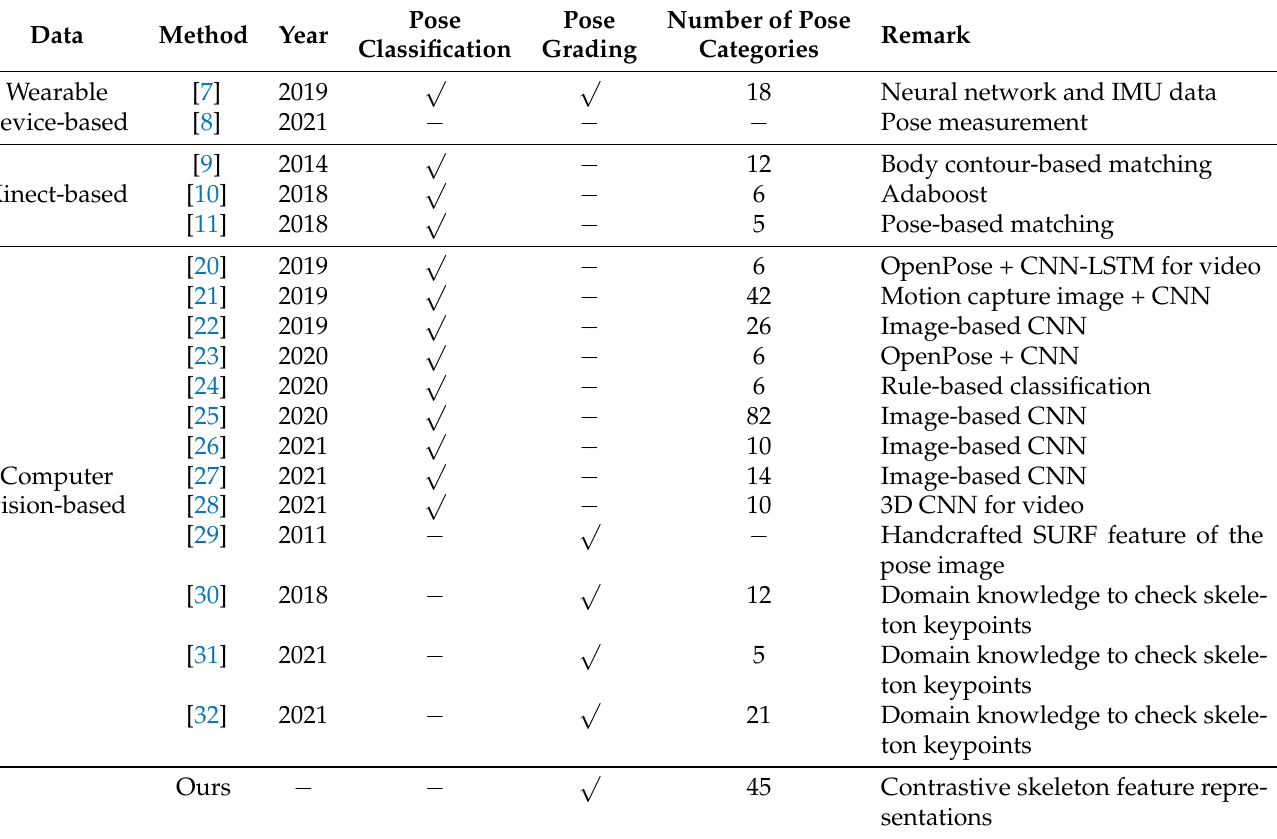
Table 1. An overview of related yoga pose classification and yoga pose grading research works in the literature. “ − ” means “not